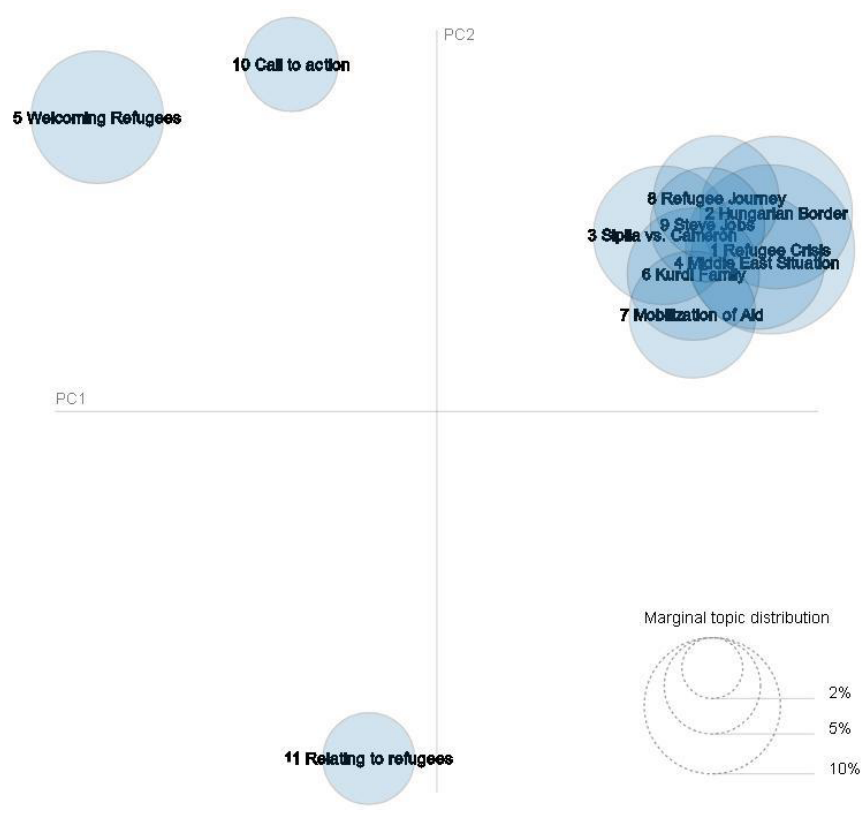
Figure 2. Intertopic distance map (via multidimensional scaling) of the Twitter